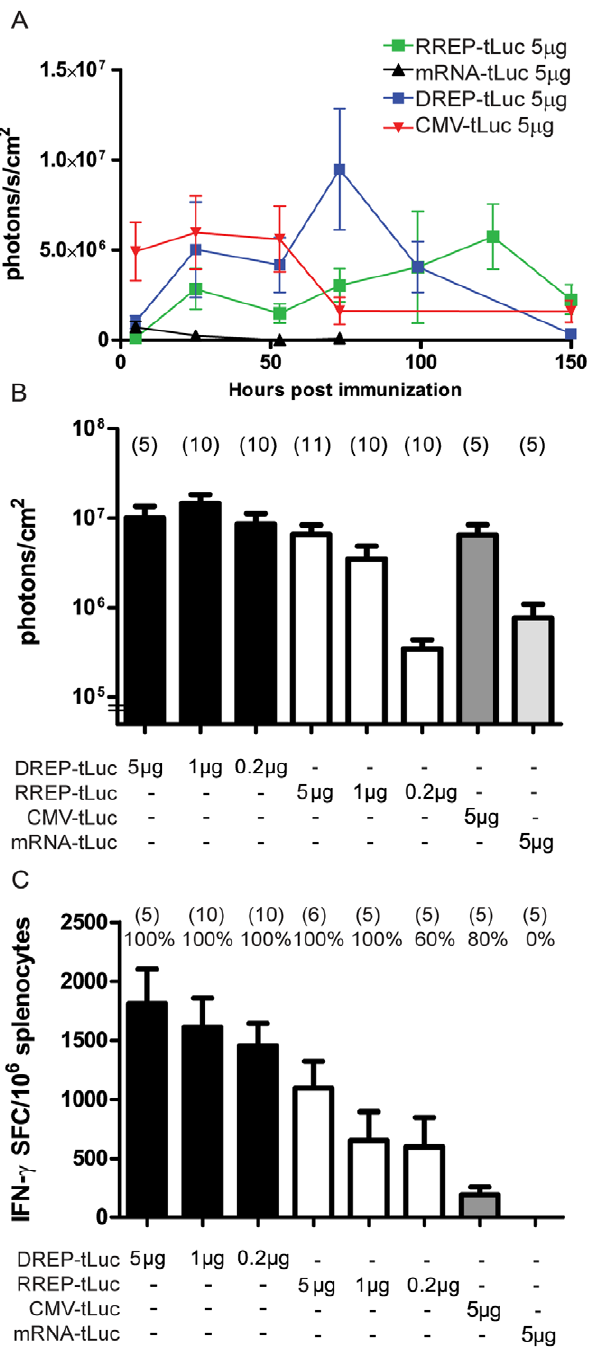
Figure 2. Invivo antigen expression and the immune response after electroporation. (a) Luciferase activity at different time points measured in photons/s/cm 2 . Data shows average activity for each group and error bars indicate SEM (number of mice per group indicated in Figure 2b). (b) Cumulative luciferase activity measured in photons/cm 2 . Data shows average accumulated luciferase activity up to 150 hours post immunization for each group (number of mice per group indicated in parentheses above each bar) with error bars showing standard error of the mean. (c) Antigen-specific IFN- c positive CD8 + T cells per million splenocytes 10 days post-immunization. Data shows average number of positive cells with error bars showing standard error of the mean. The total number of mice analyzed is indicated in parenthesis and the percentage of responding mice is indicated above each group.